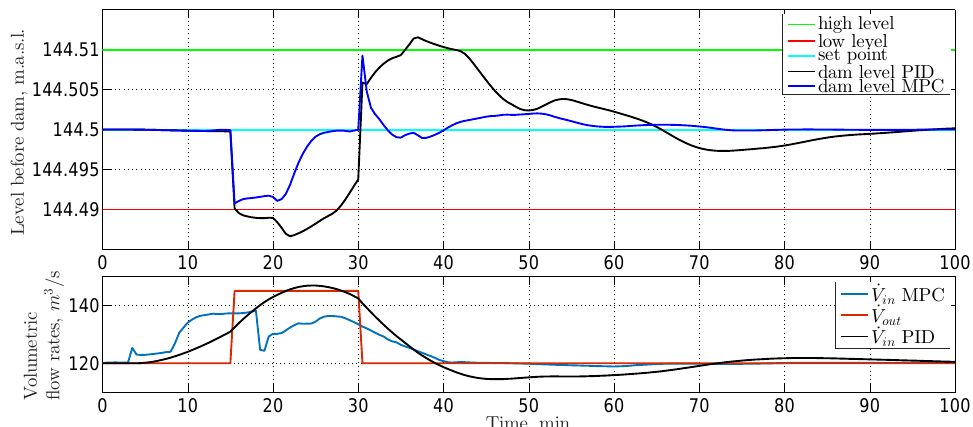
Figure 16: Comparison of MPC and PID controllers, where the inlet flow rate is a control signal.